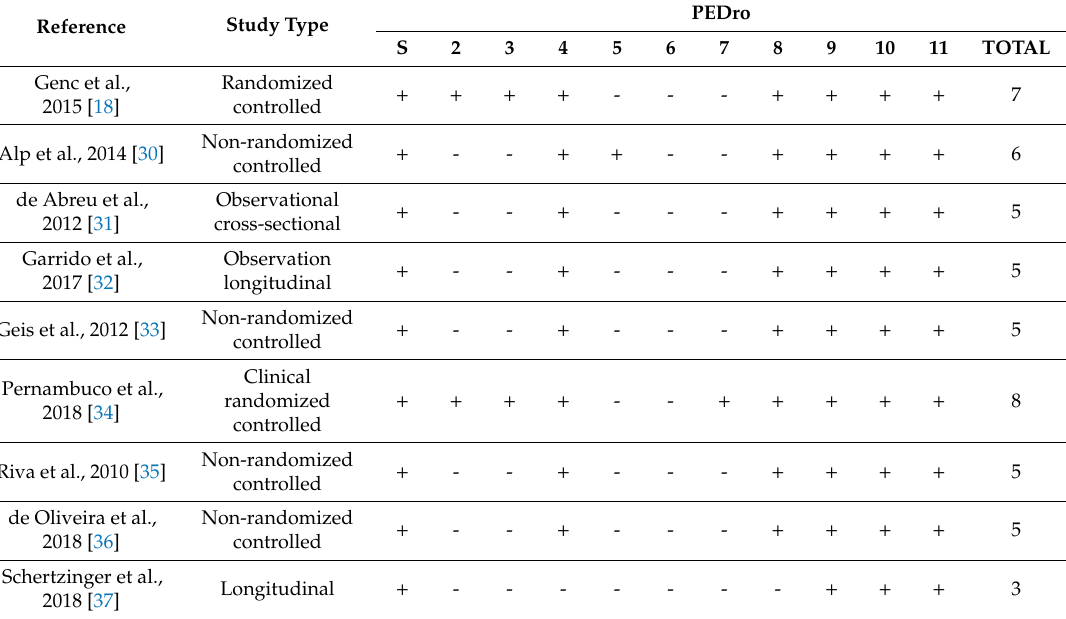
Table 1. PEDro scores of the studies